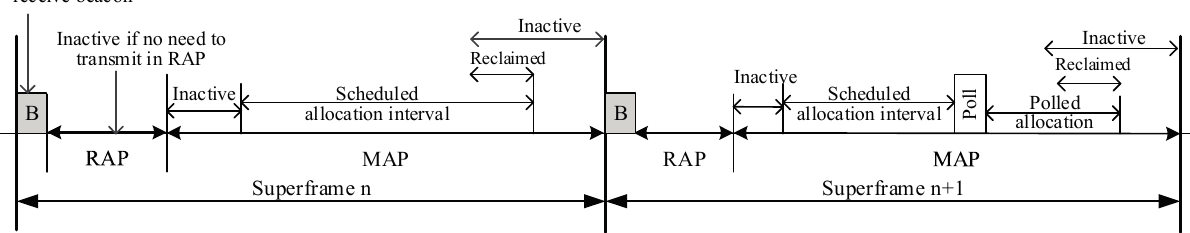
Figure 8. Inactive period in